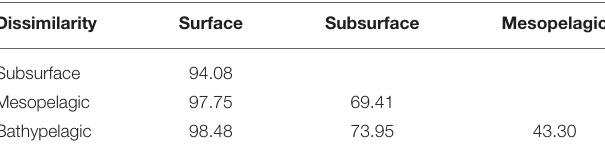
TABLE 4 | Dissimilarity index among the different layer groups estimated based on the 16S rRNA gene.